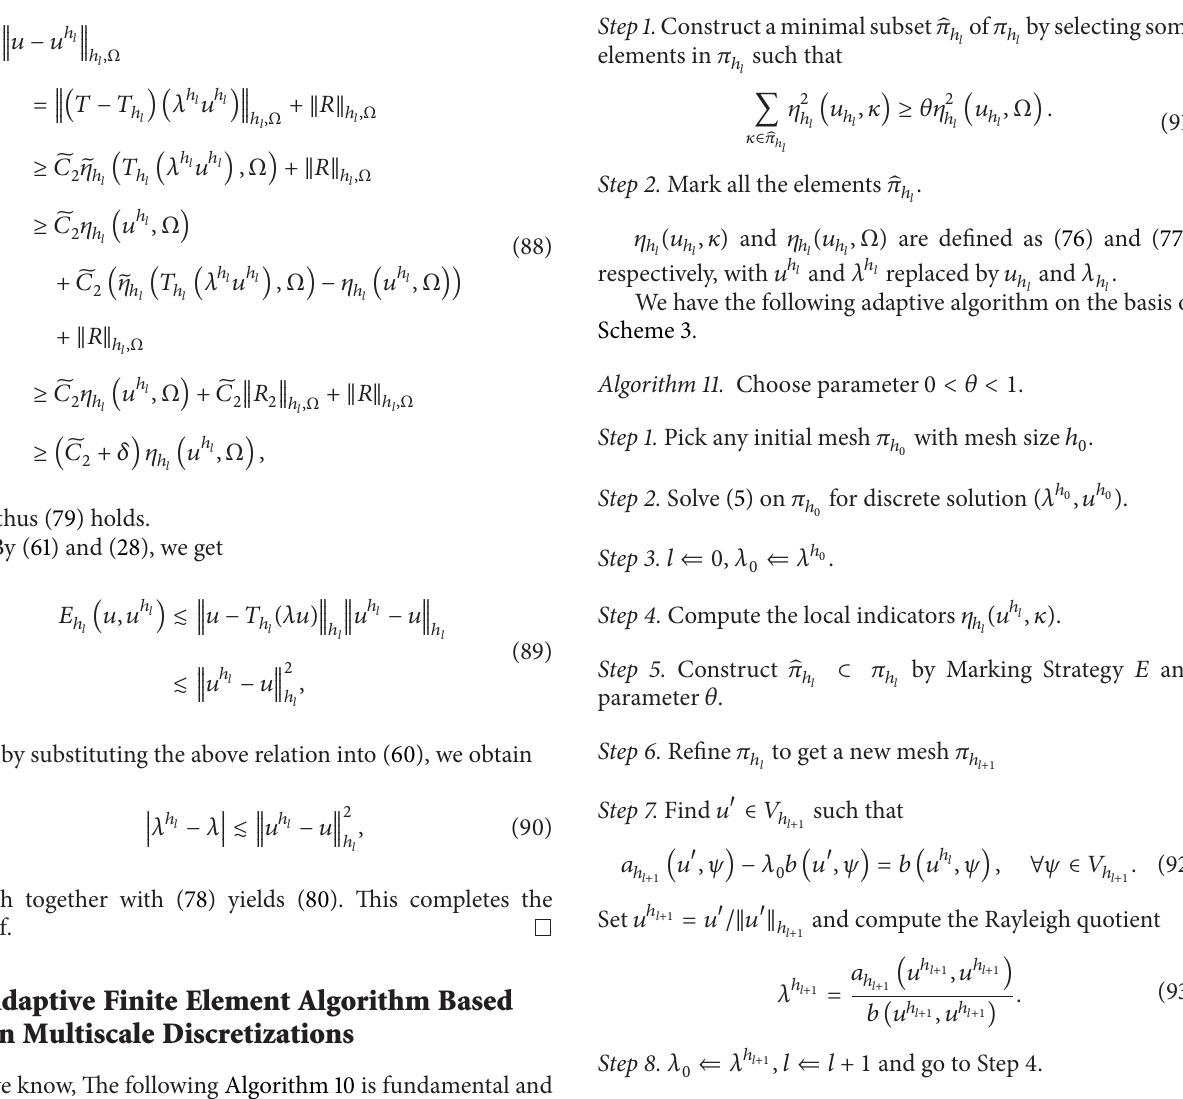
Algorithm 11. Choose parameter 0 < 𝜃 < 1